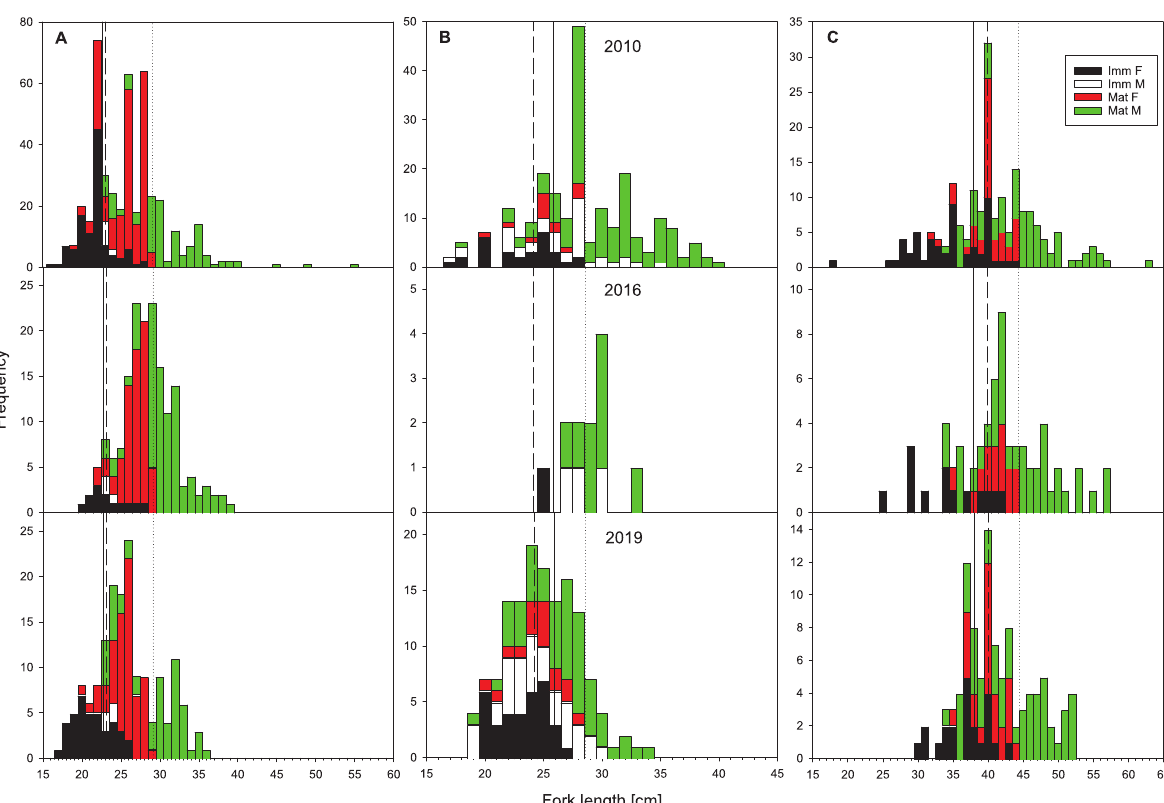
Figure 9. Size class distribution of three exploited reef fishes from three market surveys in Fiji. A Lutjanus gibbus ; B Parupeneus indicus ; C Chlorurus microrhinos . Solid line = female L production. Note that x- and y- axis scales